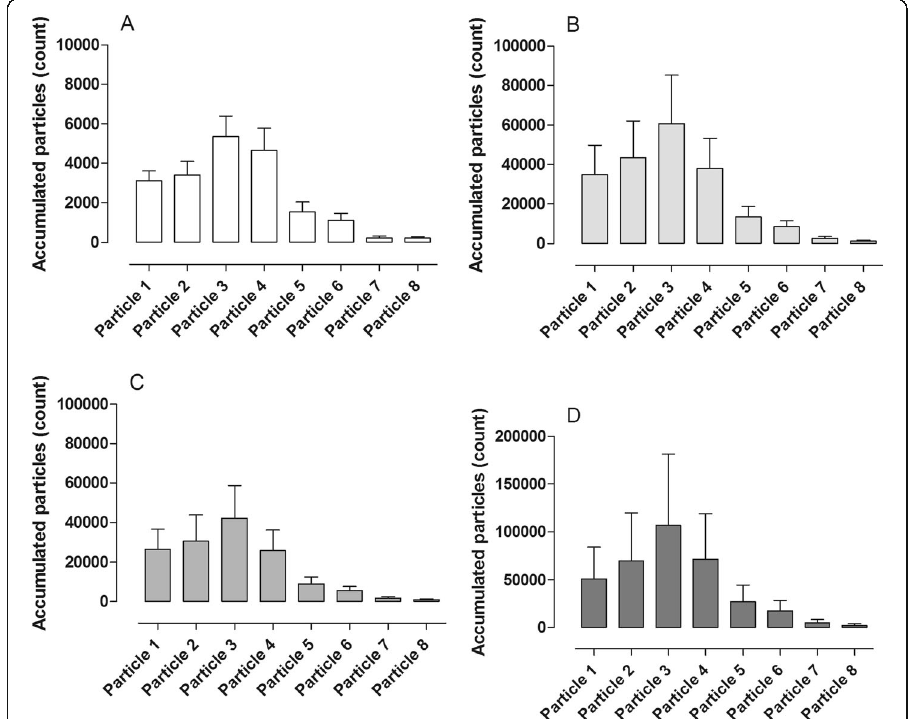
Fig. 5 Different drugs were injected into the ex vivo lung perfusion (EVLP) circuit. Distribution of different particle sizes at a baseline, and after injection of b potassium (K), c norepinephrine (NA), and d niprid. Note the differences in the total amount of particle count in the different settings; interestingly, the same particle size distribution was seen in all the settings. Volume-controlled ventilation (VCV) with small tidal volumes 6 – 8 ml/kg, breathing frequency at 16, and PEEP at 2 (VCV 1 ) was used during all